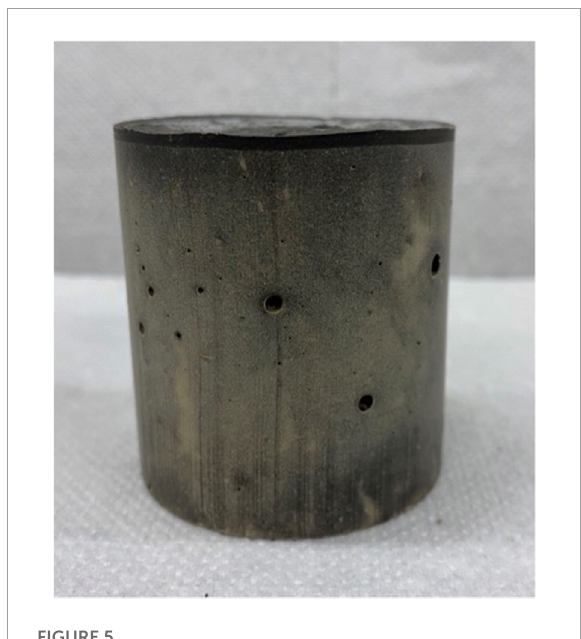
FIGURE 5 Example of hardened geopolymeric monolith.